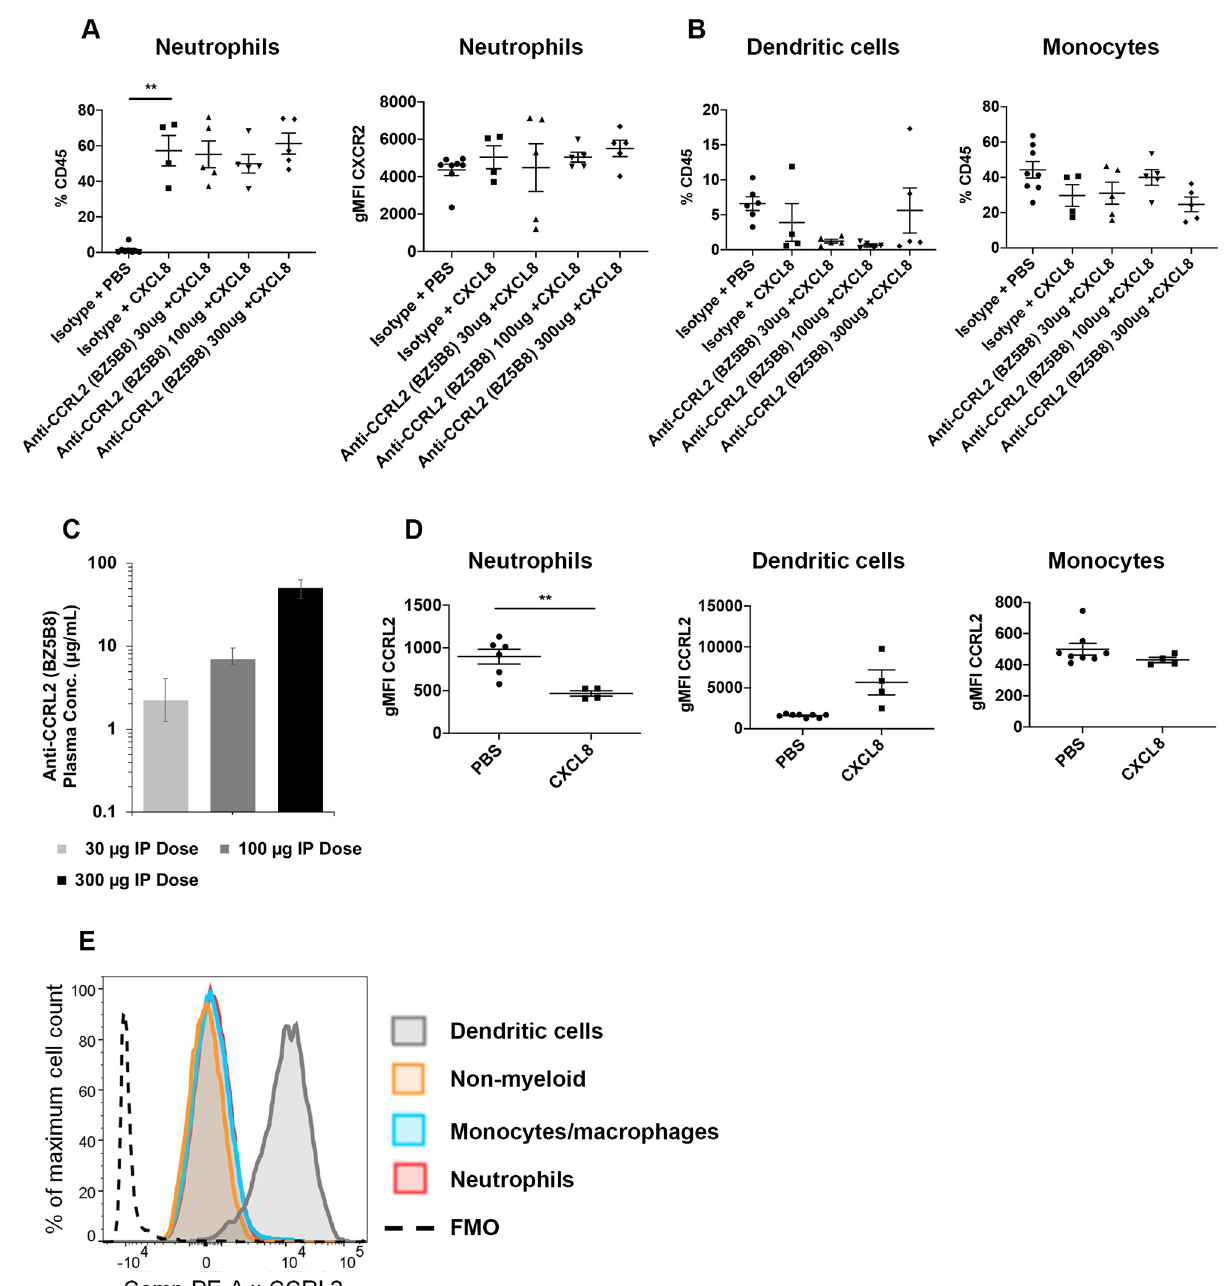
Fig 4. Flow cytometric analysis of peritoneal leukocytes populations following BZ5B8 administration in vivo. Female C57BL/6 mice were injected with anti-CCRL2 antibody BZ5B8 or isotype control intraperitoneally (IP), followed by human CXCL8 or PBS IP injection to induce the model. Peritoneal lavages were harvested 4 h later for flow cytometry analysis. (A) Percentages of neutrophils ( left) out of total CD45+ leukocytes in peritoneal lavages and surface expression of CXCR2 on neutrophils ( right ) are reported for each treatment group. (B) Percentages of dendritic cells (left) and monocytes (right) out of total CD45+ leukocytes in peritoneal lavages are reported for each treatment group. (C) Mouse anti-CCRL2 antibody BZ5B8 plasma concentration (Mean ± SD) 24 h after IP dose. (D) CCRL2 expression is shown on neutrophils ( left) , dendritic cells (middle) and monocytes (right) in control mice stimulated with CXCL8 or PBS control. (E) Representative histogram of CCRL2 expression on dendritic cells (grey), non- myeloid cells (CD11b-, Ly6G-) (orange), monocytes/macrophages (blue) or neutrophils (red) compared to FMO control in peritoneal lavages from CXCL8 stimulated mice. (A-B, D) Statistical analyses were performed using the Brown-Forsythe and Welch ANOVA with Dunnett’s T3 multiple comparisons test, and a unpaired t test with Welch’s correction. Statistical analyses used an alpha threshold of 0.05. Results are plotted as the Mean ± SEM. �� P <